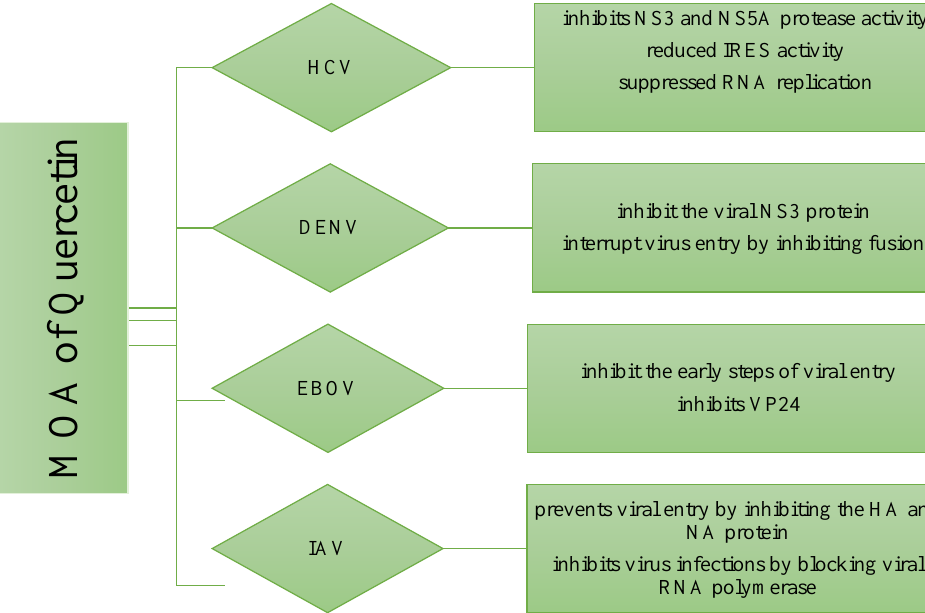
Figure 8. Differences in the mechanism of action of Quercetin for inhibiting four different types of viruses. The viral strains are denoted as hepatitis C virus (HCV), Dengue virus (DENV), Ebola virus (EBOV), and Influenzae virus (IAV).